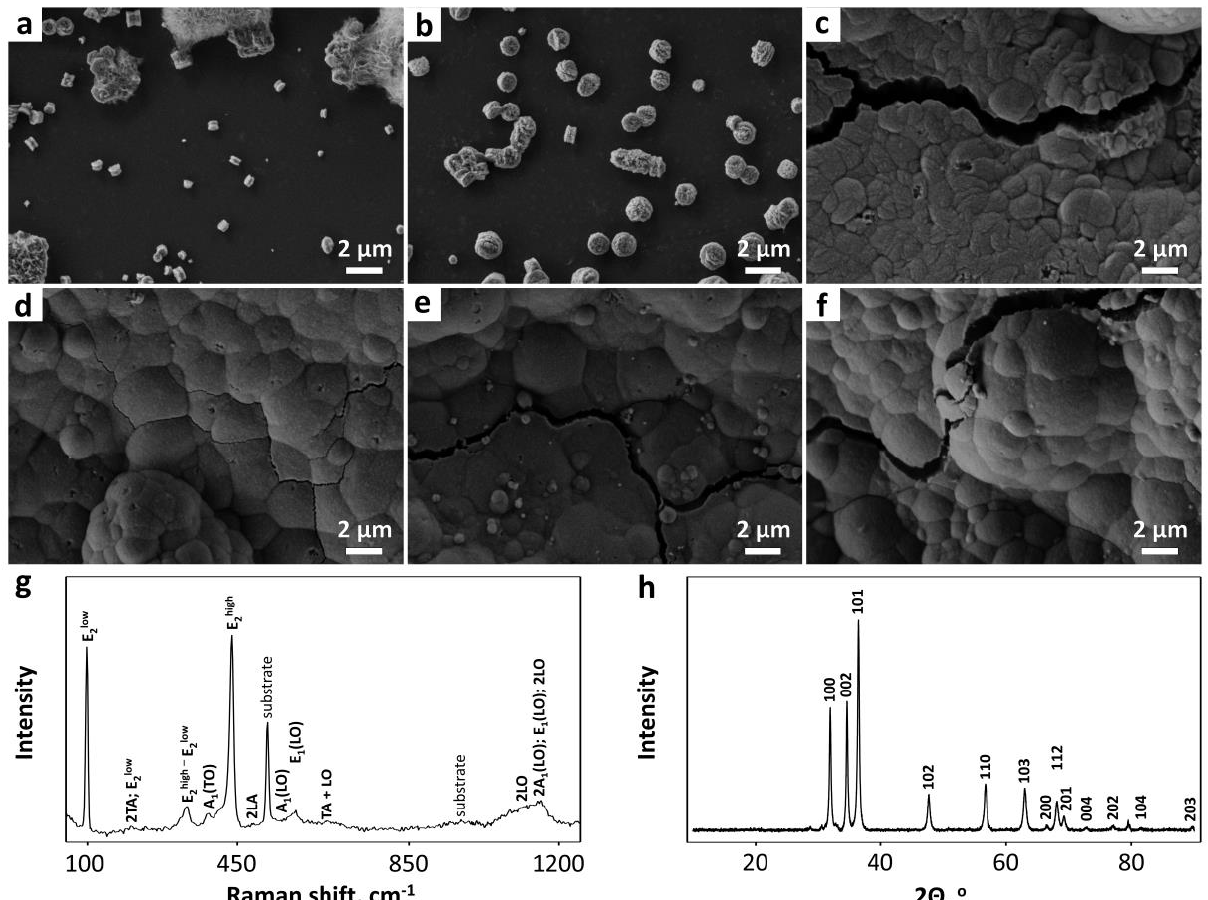
Figure 3. Morphology and structure of the electrochemically deposited ZnO layer: ( a – f ) SEM images of the oxide structures to appear in the inter-electrode space in dependence on various time: 400 s ( a ), 550 s ( b ), 700 s ( c ), 850 s ( d ), 1000 s ( e ), 1150 s ( f ); ( g ) the characteristic Raman spectrum; ( h ) XRD pattern. The characterization has been carried out for the chip which was a subject of heating at 300 ◦ C in course of